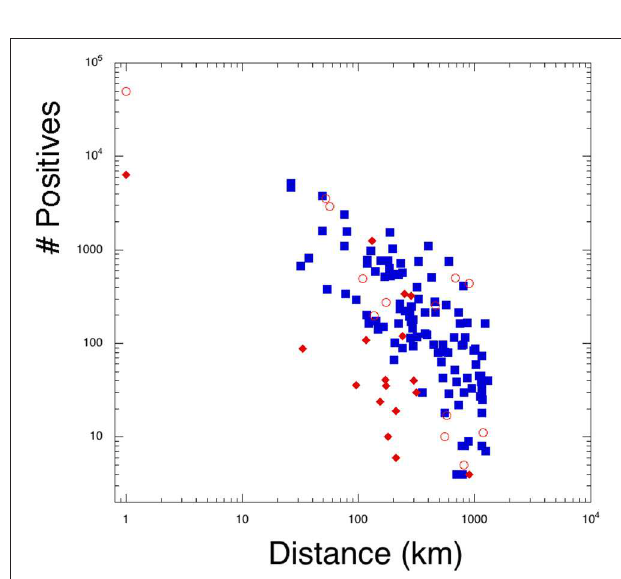
FIGURE 6 | Number of positives from the “center of infection” (on March 20, 2020). The x-axis gives the distance from Wuhan (open circles) for China, Daegu for South Korea (rhombs), and the middle of Brescia and Bergamo for Italy (squares). We located arbitrarily Wuhan and Daegu at a 1km distance and Bergamo-Brescia at 25km.